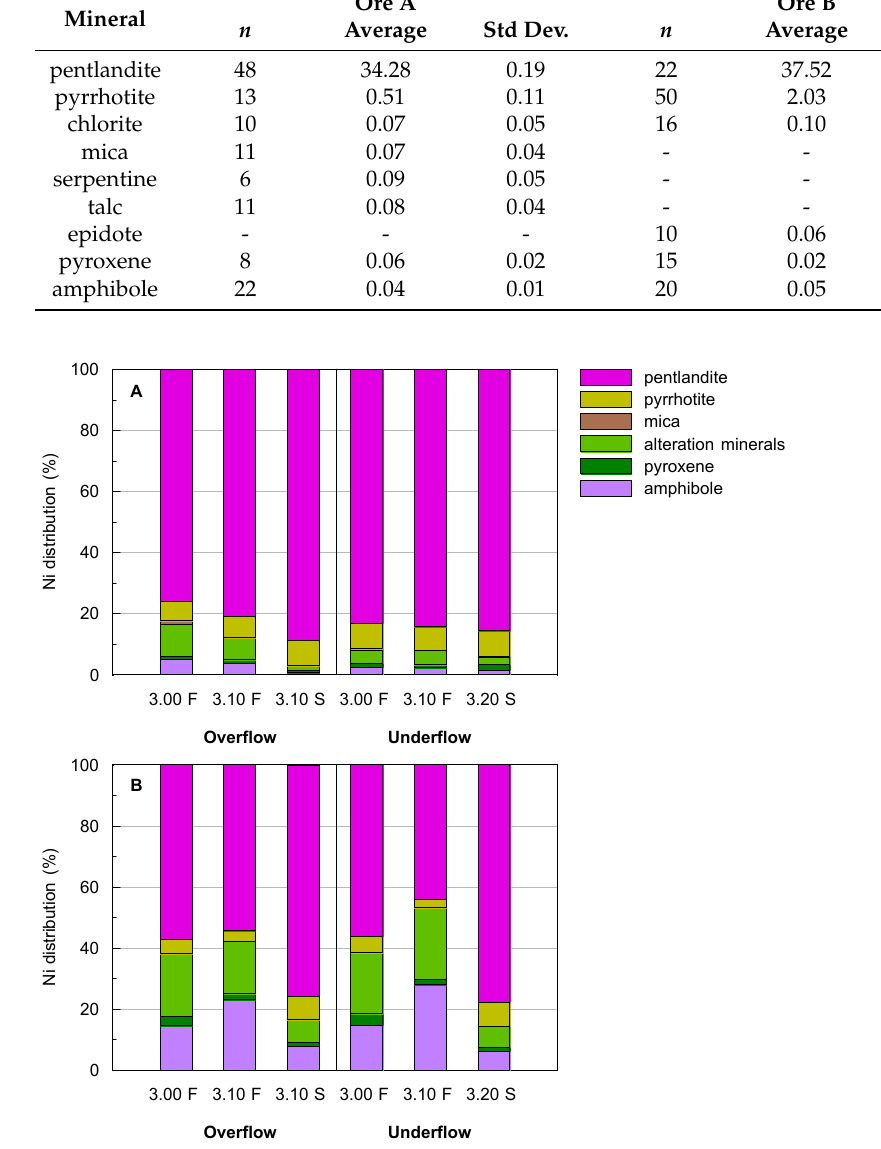
Figure 6. Nickel deportment in the DMC overflow and underflow products for ore A ( A ) and ore B ( B ). For simplification, chlorite, serpentine, talc and epidote are grouped as ‘alteration minerals’.